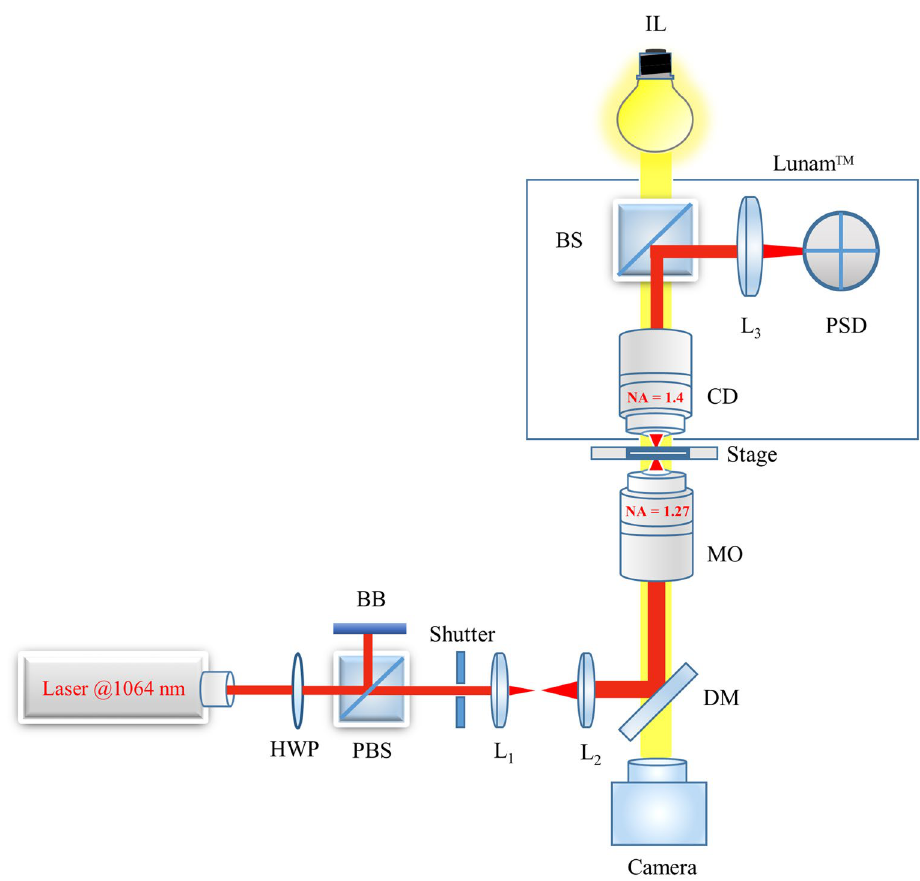
Figure 6. Schematic representation of the stage-driven OT setup with a position-sensitive detector in the back focal plane. An inverted microscope has been extended by both a commercially available back-focal-plane interferometer and a piezo nano-positioning stage. A continuous-wave diode-pumped laser emitting at 1064 nm is employed for optical trapping. HWP half wave plate, PBS polarizing beam splitter, BB beam blocker, Li Lens, DM Dichroic mirror, MO microscope objective, CD condenser, BS beam splitter, PSD position sensitive device, IL illumination